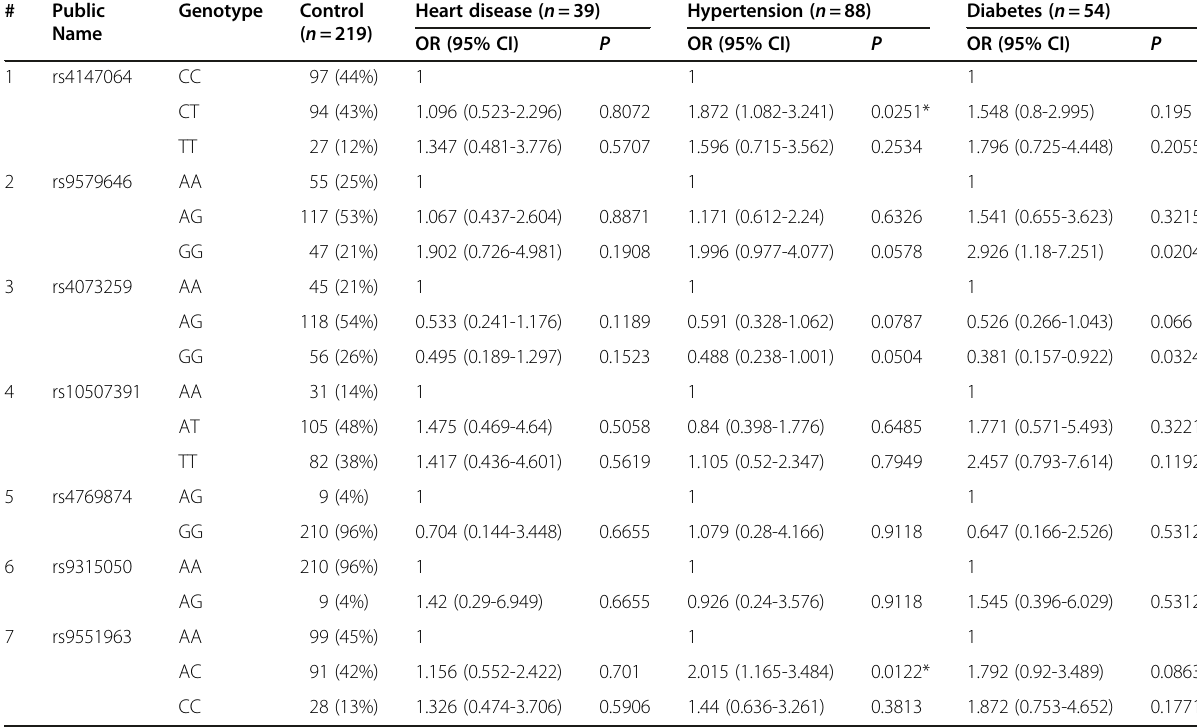
Table 4 Comparison of genotype distribution between control and case groups stratified into heart disease, hypertension, and